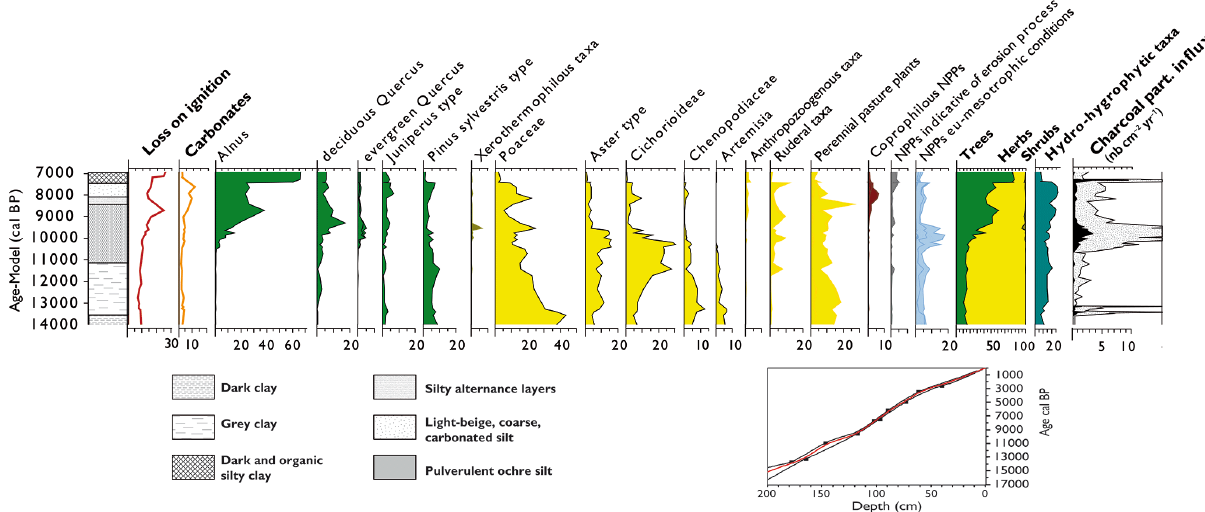
Figure 9. Diagram from the Dik4 core with its age–depth model. Loss on ignition and carbonate content of the sediment expressed in % of the total sediment. Charcoal influx expressed in cm − 2 yr − 1 . Selected pollen and NPP groups expressed in % (see Glais et al.,